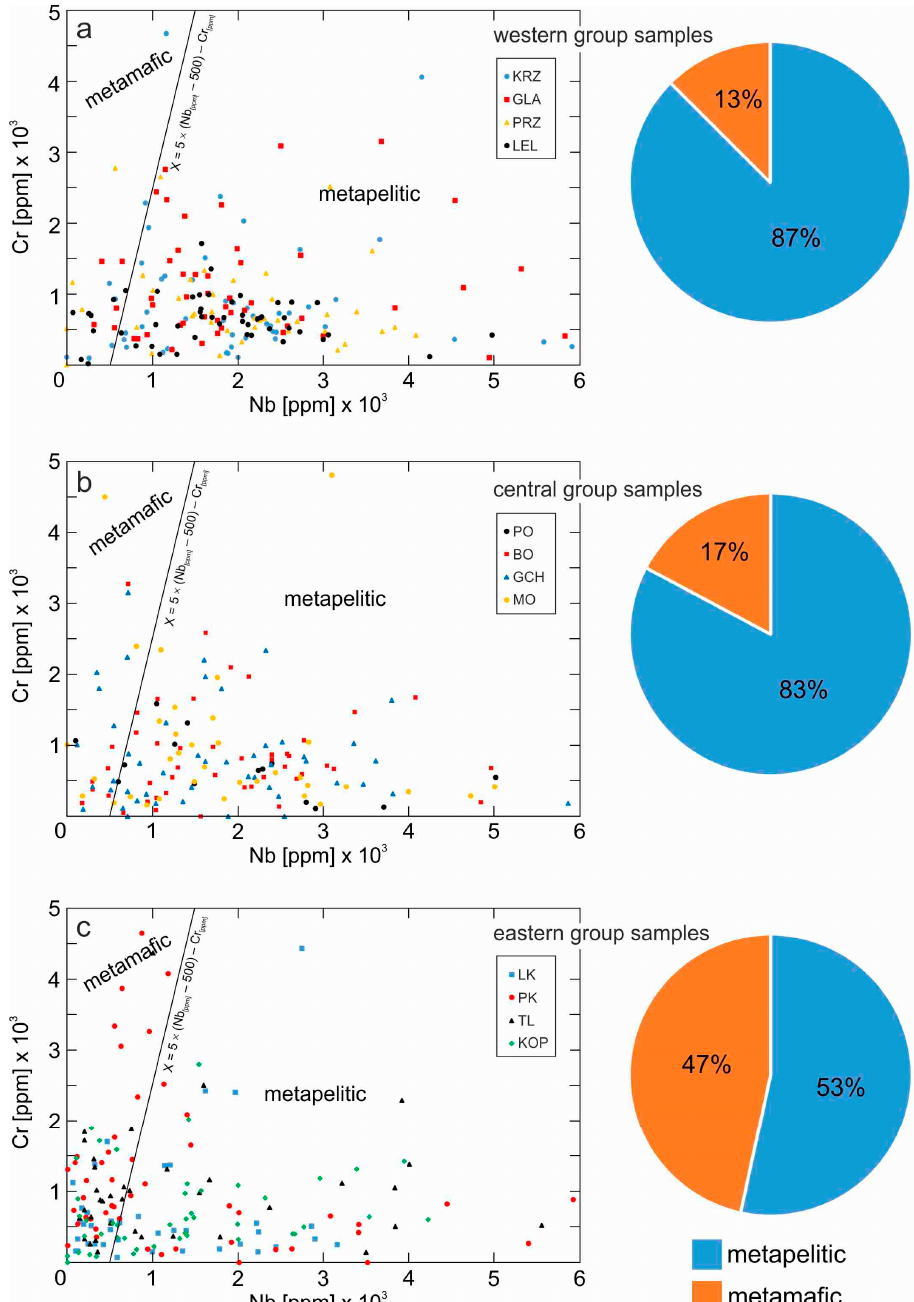
Figure 7. Cr-Nb plots showing contrasting rutile provenance and pie charts of relative abundance of metamafic and metapelitic rutiles in the distinguished western ( a ), central ( b ), and eastern ( c ) groups. Discrimination of metamafic and metapelitic rutile is based on [47]. Details of sample abbreviations and localization are provided in Table 1.